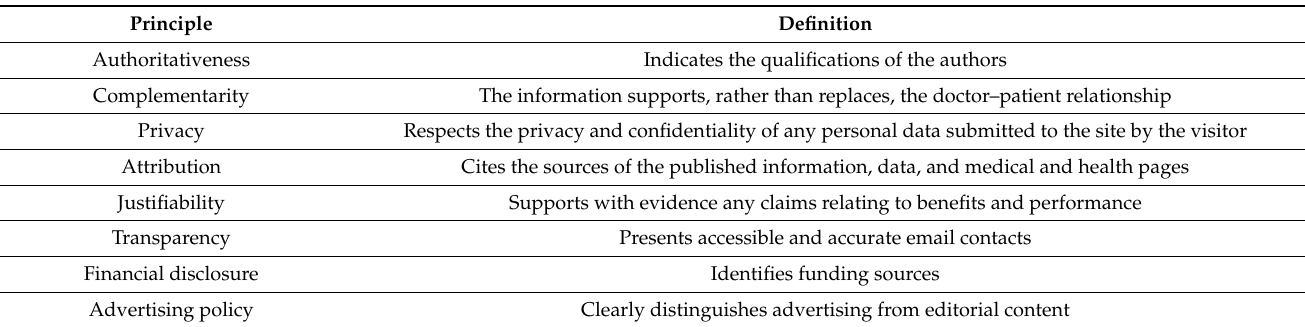
Table 1. The Health on the Net Foundation code of conduct tool (HONcode).